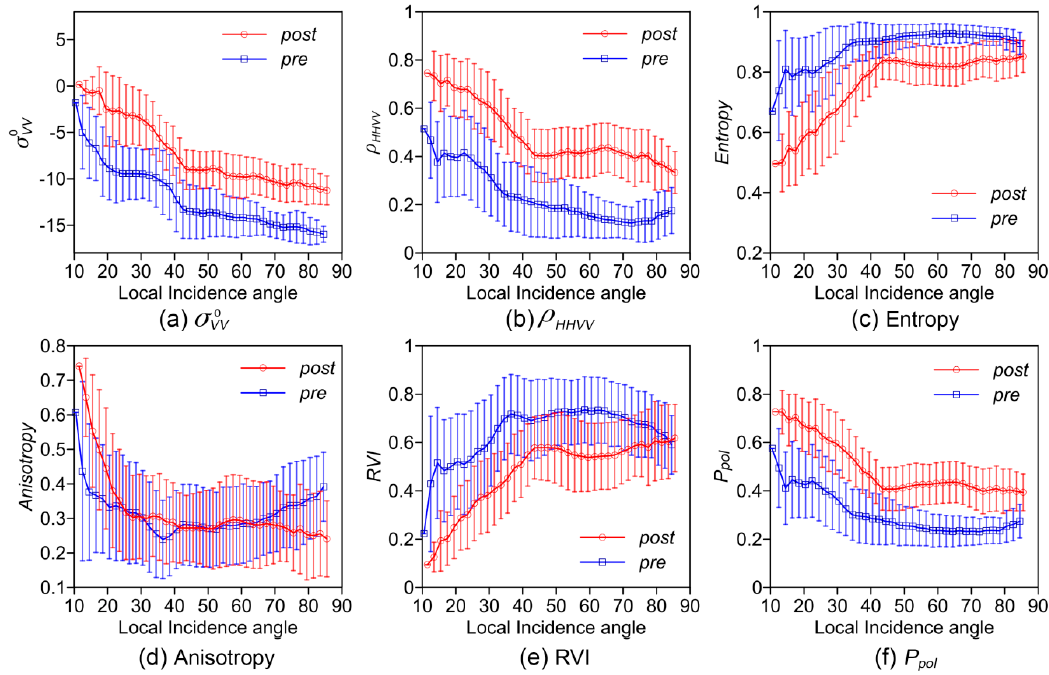
Figure 6. Changes of the polarimetric parameters ( a ) σ 0 , ( b ) ρ HHVV , ( c ) entropy, ( d ) anisotropy, ( e ) RVI, and ( f ) P pol in non-forested areas with respect to the local incidence